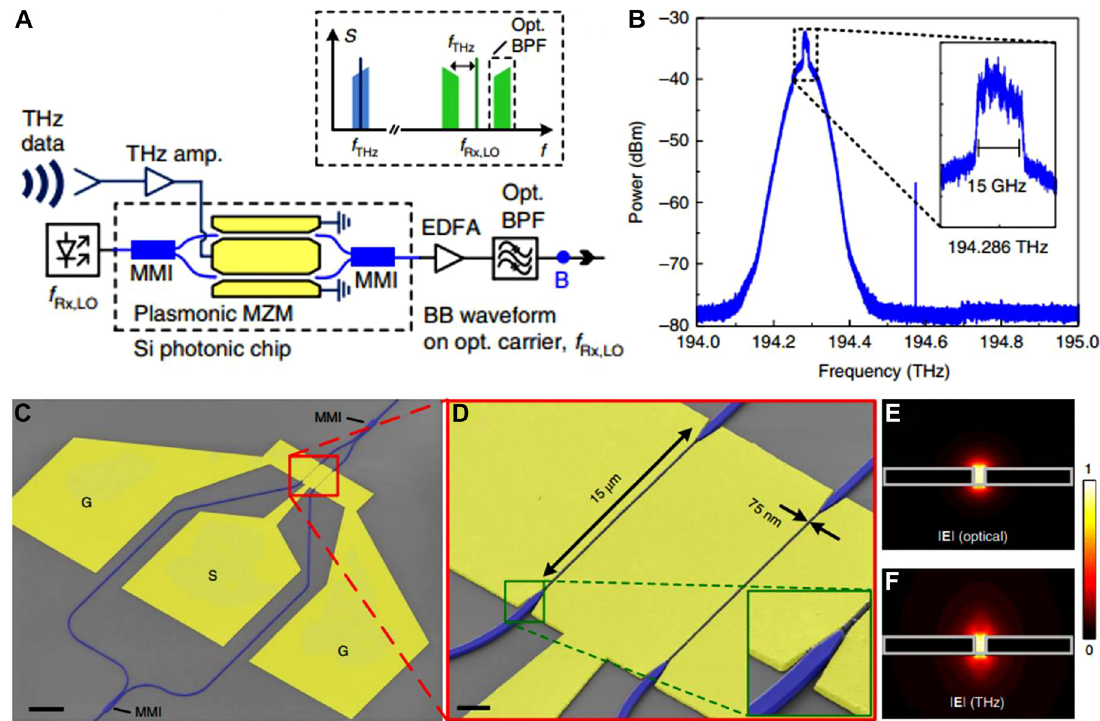
Figure 21: Nanogap-enabled THz-to-optical conversion of THz wireless signal to fiber-optic systems. (A) Concept of THz-to-opticalconversion,whereTHz input is fed to a plasmonicMach – Zehndermodulator andcreatessidebandsof anoptical signal. Optical band pass filter is used to select one of the modulated sidebands. (B) Spectrum of a lower sideband, containing a 15 GBd quadrature phase-shifting keying (QPSK) signal centered at 194.286 THz. (C) and (D) False-colored SEM images of the plasmonic Mach – Zehnder modulator, comprisingorganicelectro-optic material fi lled ina 75 nm-widemetallicslit. (E)and (F) Field pro fi le of the optical andTHz modes strongly con fi ned to the gap. Reproduced with permission from